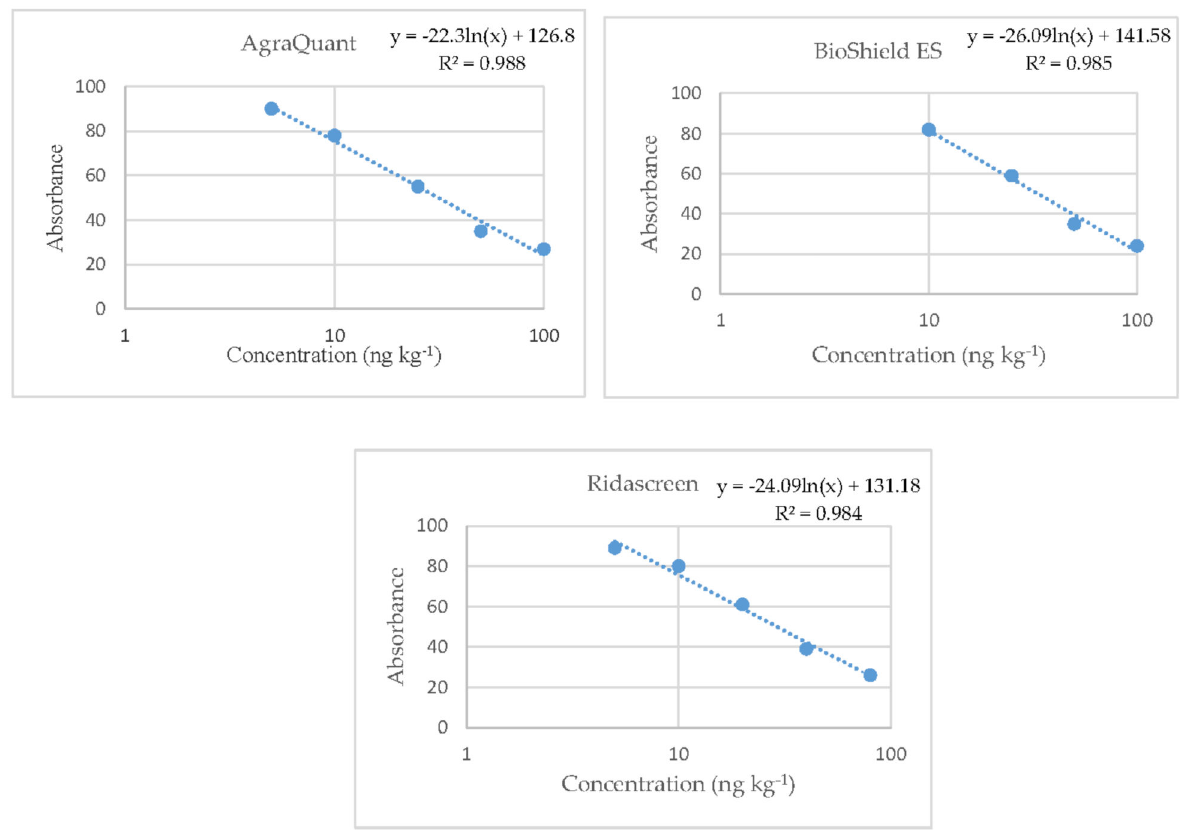
Figure 3. Reference curves of the three Enzyme-Linked-Immunosorbent Assay (ELISA) kits where the straight lines are linear regressions of the absorbance